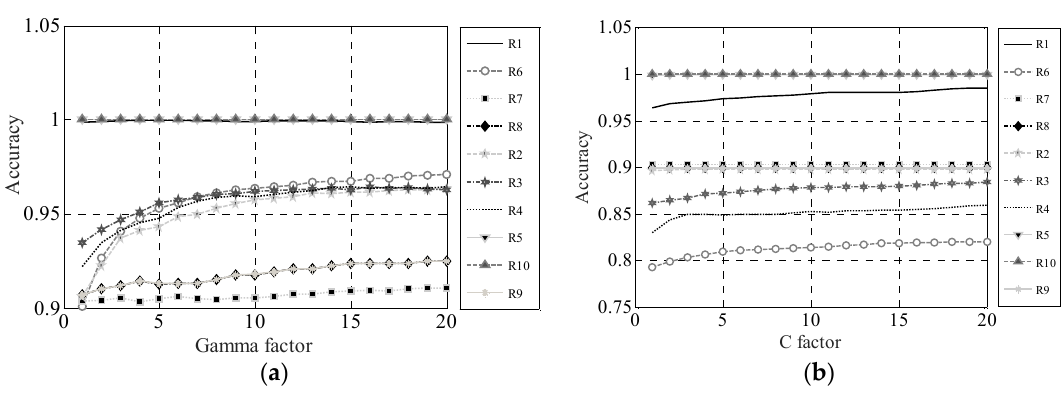
Figure 7. Support vector machine (SVM) performance in function of adjustment of its hyper-parameters: ( a ) SVM performance when it was varied with Gamma factor with C = 1; ( b ) SVM performance when it was varied with C factor with γ = 1 .